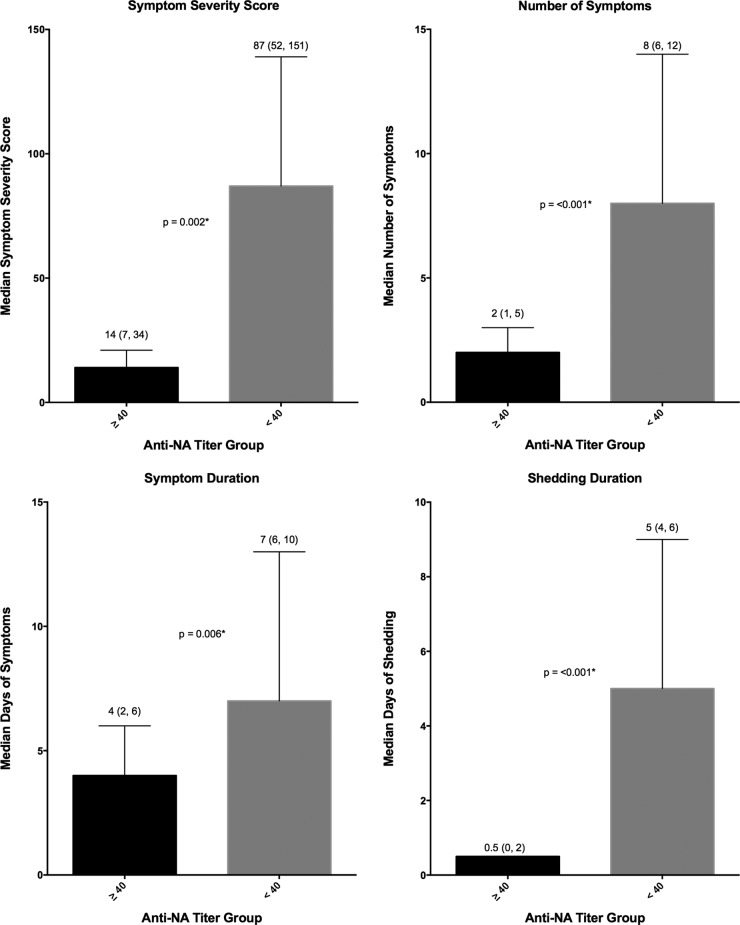
Quantity and timing of viral shedding and composite symptoms. The mean composite symptoms and shedding based on HAI titer groups are shown. Overall, there was primarily a decrease in the duration of shedding and symptoms in those with a higher baseline HAI titer. Values are means ± standard errors of the means (SEM) (error bars).